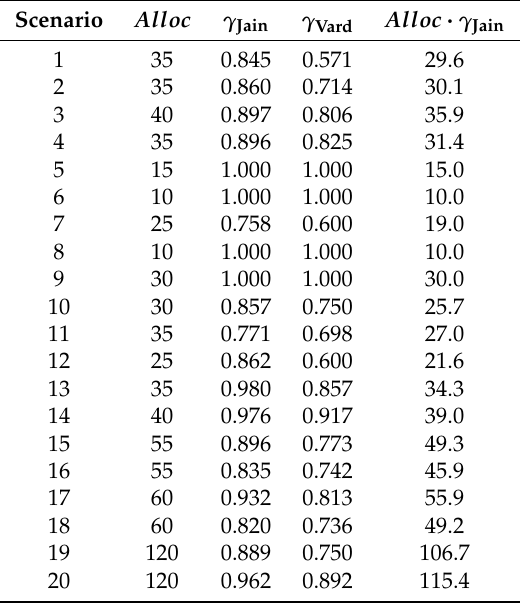
Table 11. Performance evaluation for BSF-II. Alloc values in